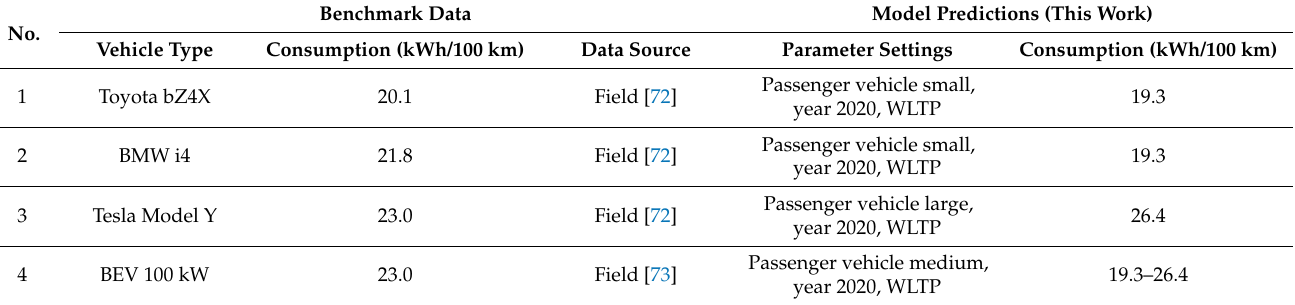
Table 16. Comparison between experimental data on BEV consumption from the literature and this work.